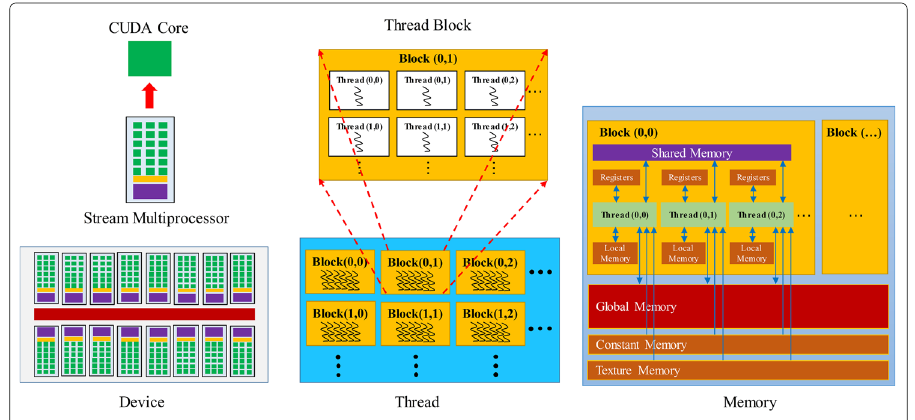
Fig. 8 Organization of CUDA threads for NVIDIA’s GPU and its mapping to hardware